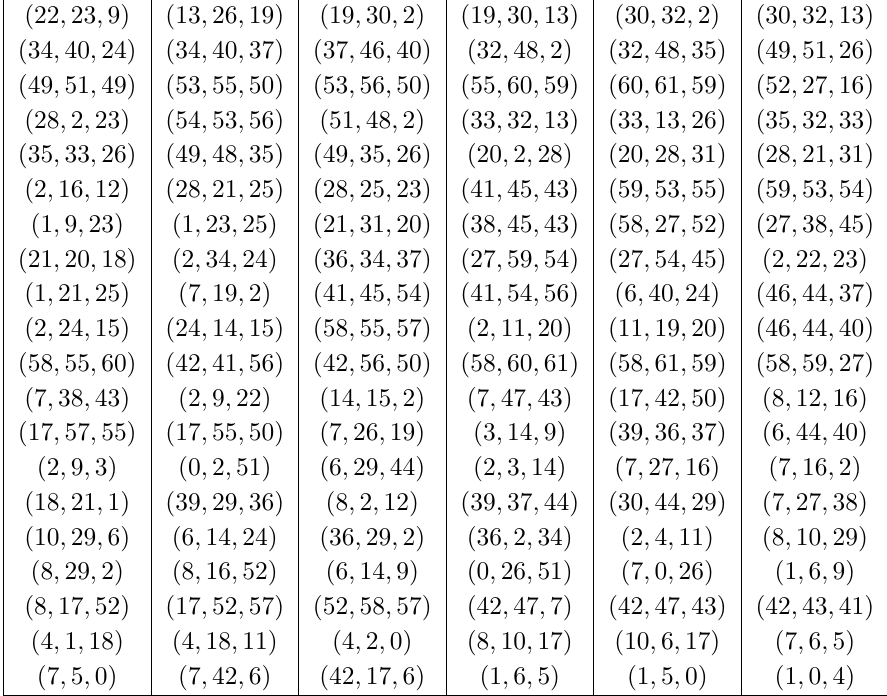
Table 5 . The list of 3D fans of the exotic starting point B ex . We use ( i; j; k ) to denote the triple element set ( v i ; v j ; v k